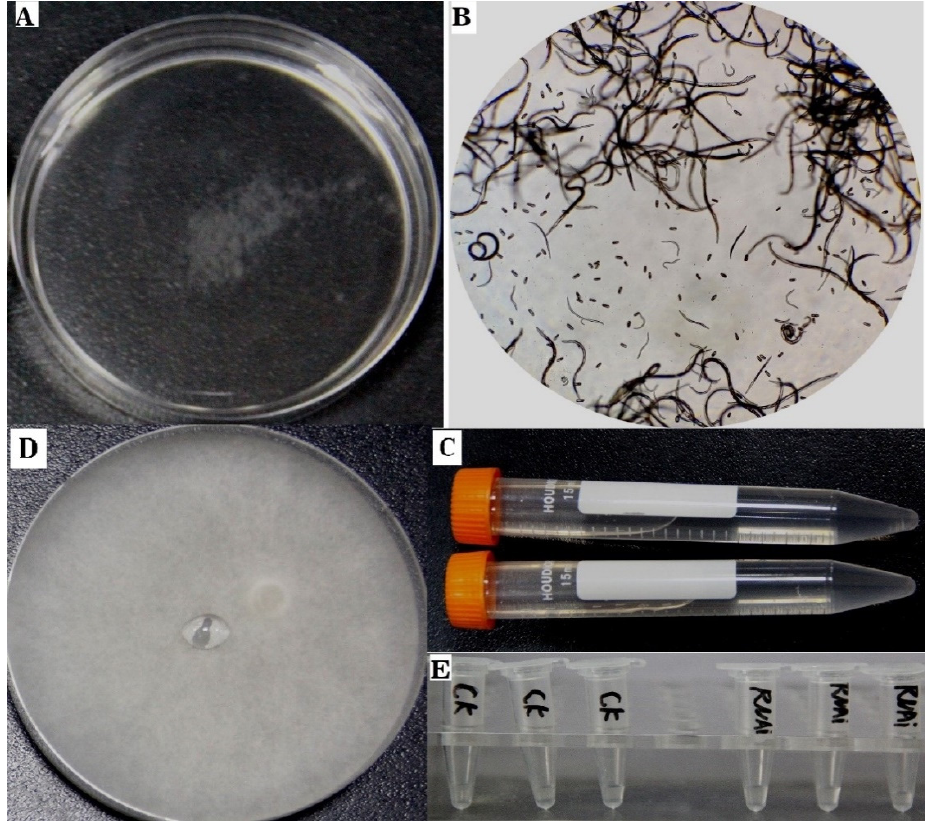
Figure 2. PWN culture and RNAi. ( A ): The PWN suspension was placed in a dish, and the eggs adhering to the bottom of the dish were collected every 6 h. ( B ): Eggs adhering to the bottom of the dish. ( C ): The collected PWN eggs were placed in an Eppendorf tube and incubated at 25 °C for 36 h. All the eggs hatched into second-stage PWN. ( D ): The second-stage PWN juvenile suspension was inoculated into the freshly grown Botrytis cinerea medium and cultured for 48 h (when the majority of nematodes were 4th stage juveniles). ( E ): RNAi was performed on PWN at 25 °C (immersion method).